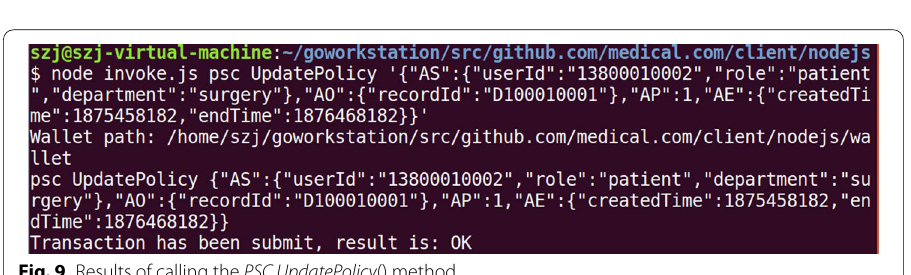
Fig. 9 Results of calling the PSC . UpdatePolicy () method